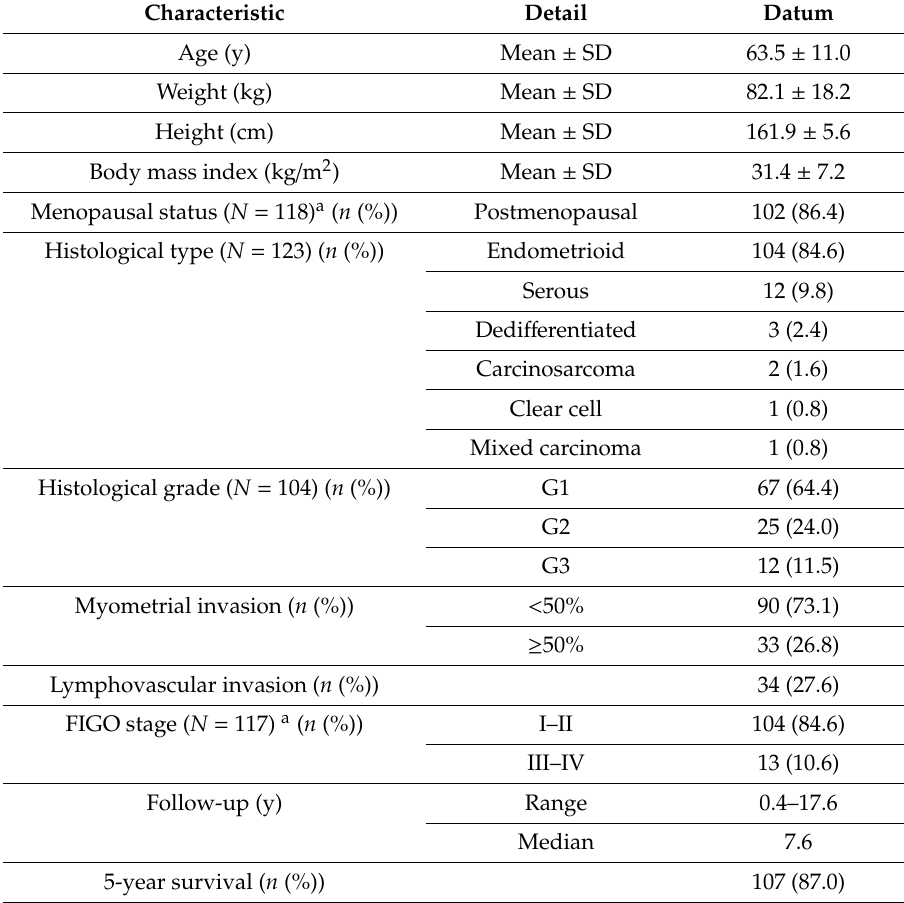
Table 1. Clinical and histopathological data for the patients with endometrial